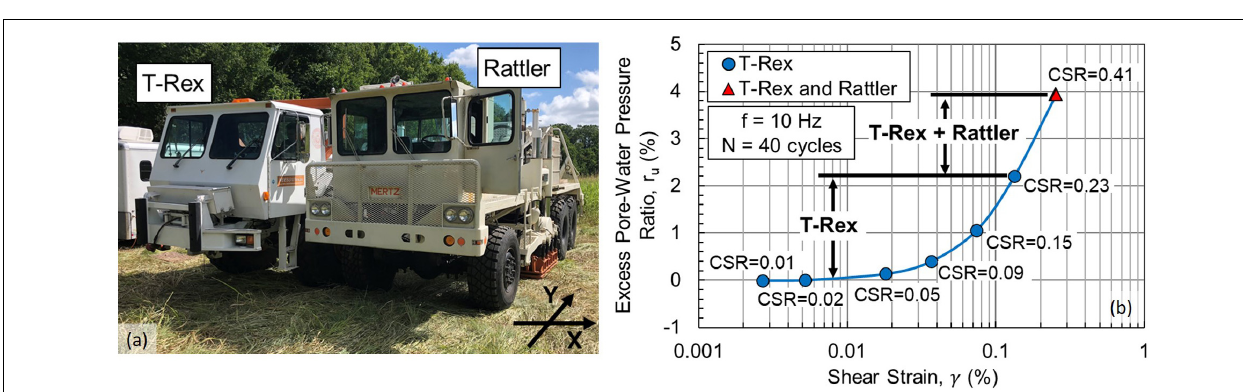
Figure 8b . Utilizing two mobile shakers approximately doubled the induced shear strain level, compared to using only one mobile shaker. The second new technique is still under